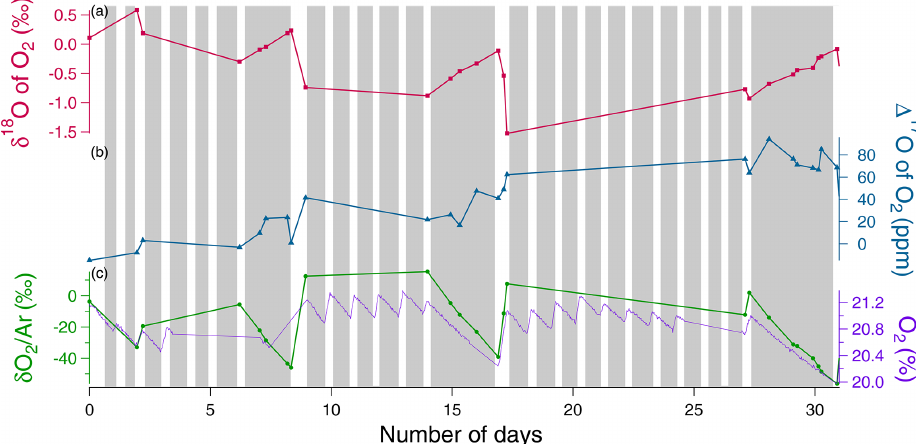
Figure 4. Example of the evolution of the different concentrations and isotopic ratios in the sequence 1 of photosynthesis and dark respiration experiment in the closed chamber over 31d (day 0 is the beginning of the sequence). Grey rectangles correspond to night periods and white rectangles to light periods. (a) δ 18 O of O 2 (red) variations. (b) (cid:49) 17 O of O 2 variations (blue). (c) Dioxygen concentration (purple) from the optical sensor and δ O 2 / Ar variations (green) measured by IRMS. Table 2. Summary of the mean values of the isotopic discriminations and θ values for Festuca arundinacea of all sequences of (1) the soil respiration experiment and of (2) the respiration and photosynthesis experiment and the number of data on which they were calculated ( ∗ is the value for θ photosynthesis that depends on the determination of the δ 17 O of atmospheric O 2 vs. δ 17 O of VSMOW). We provide here the two different possible estimates using either 12.03‰ (Luz and Barkan, 2011) or 12.08‰ (Barkan and Luz, 2005): value determined with δ 17 O = 12.03‰ / value determined with δ 17 O = 12.08‰. Isotopic discriminations and θ Average Standard deviation No. of values of Festuca